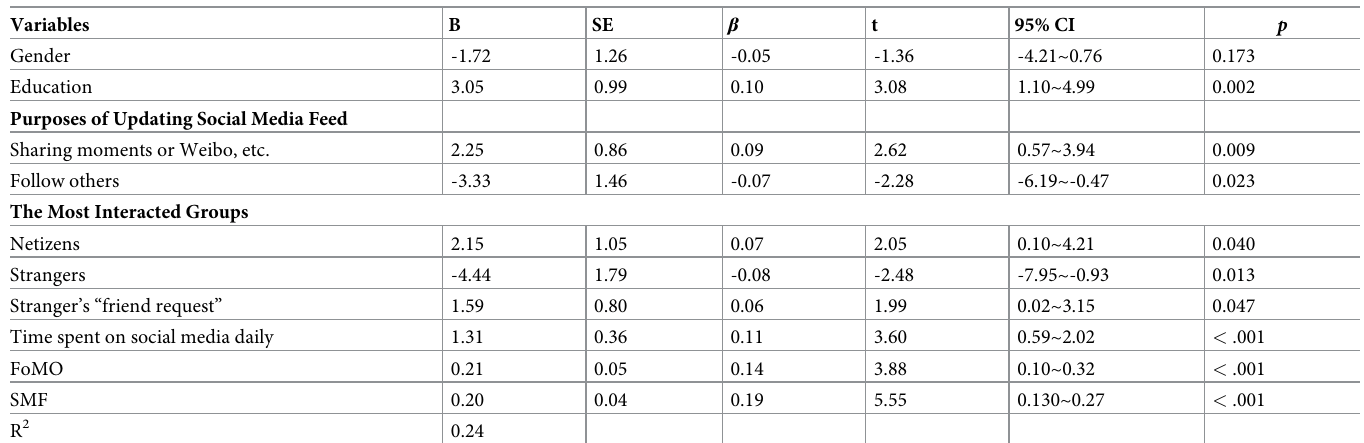
Table 2. Determinants of self-disclosure in social media among nursing students (n = 1054).